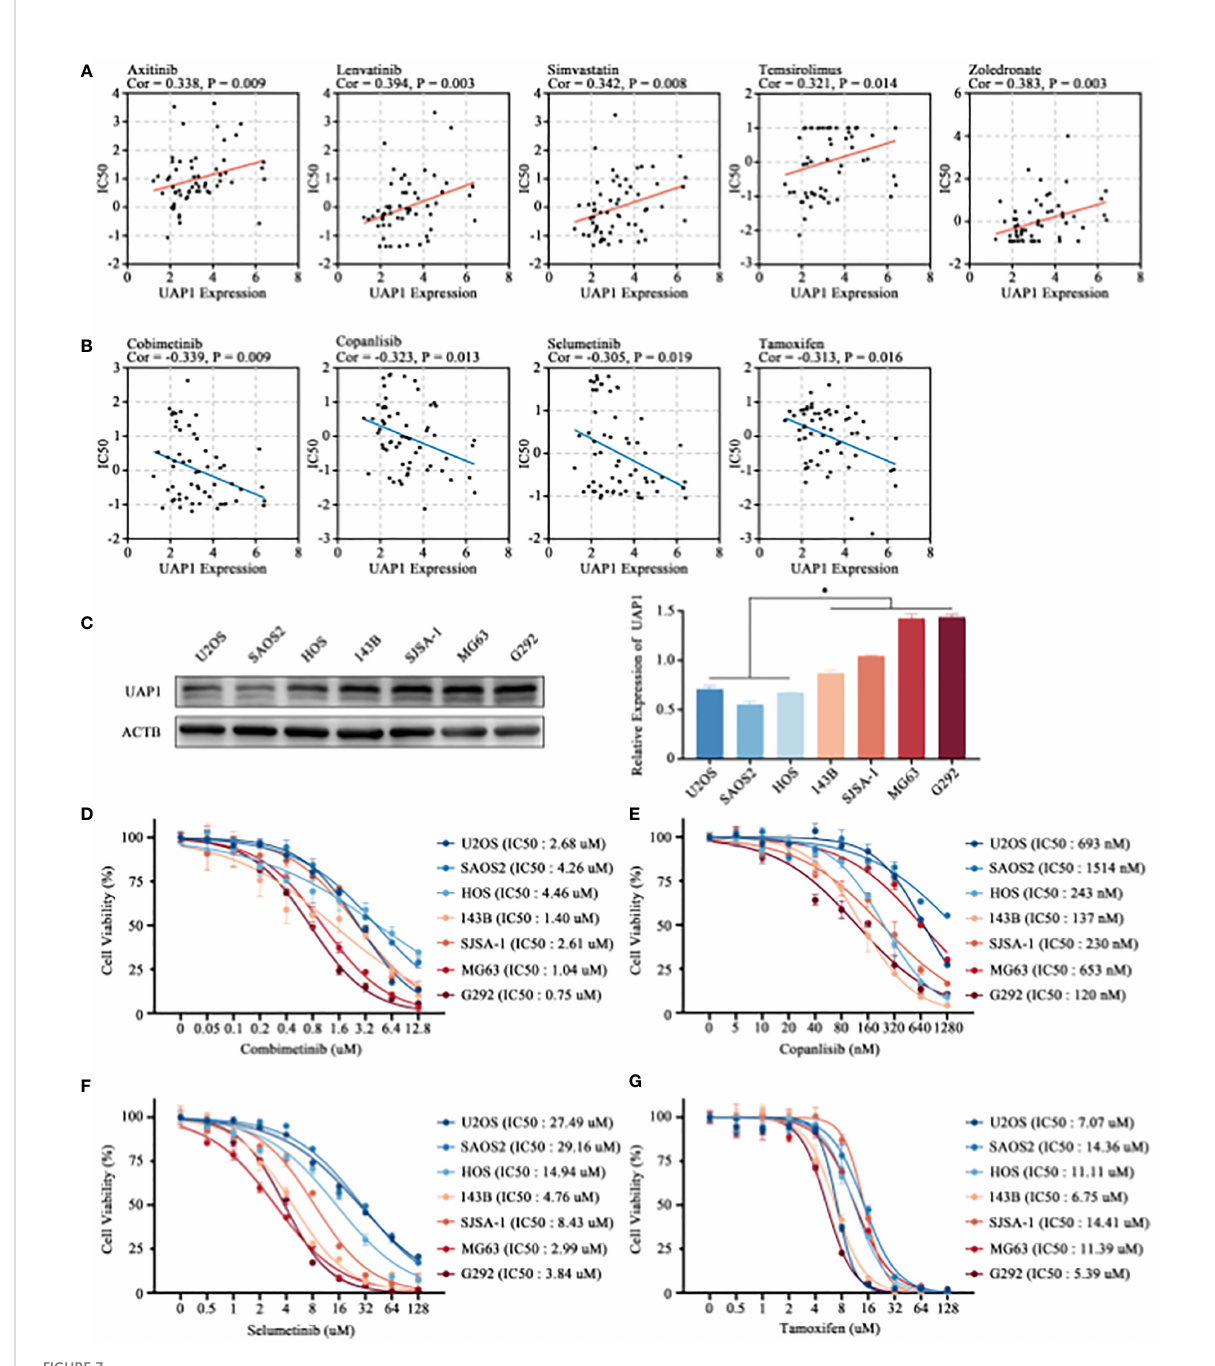
FIGURE 7 Prediction of drug sensitivity targeting UAP1 and in-vitro cell veri fi cation. (A, B) Correlation analysis between the UAP1 expression and drug sensitivity in the NCI-60 cell lines. (C) The level of UAP1 protein expression in OS cell lines, as detected by western blotting. (D – G) IC50 of antineoplastic drugs including cobimetinib (D) , copanlisib (E) , selumetinib (F) and tamoxifen (G) in OS cell lines according to the CCK-8 assay. “ * ” represents